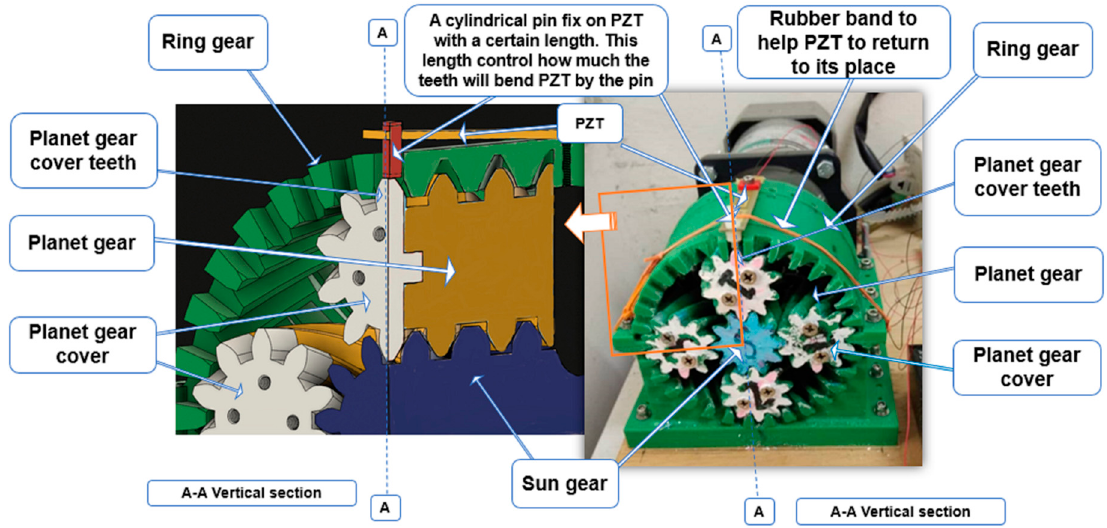
Figure 3. Test rig harvester prototype with a section view in the A-A vertical line and all part names.